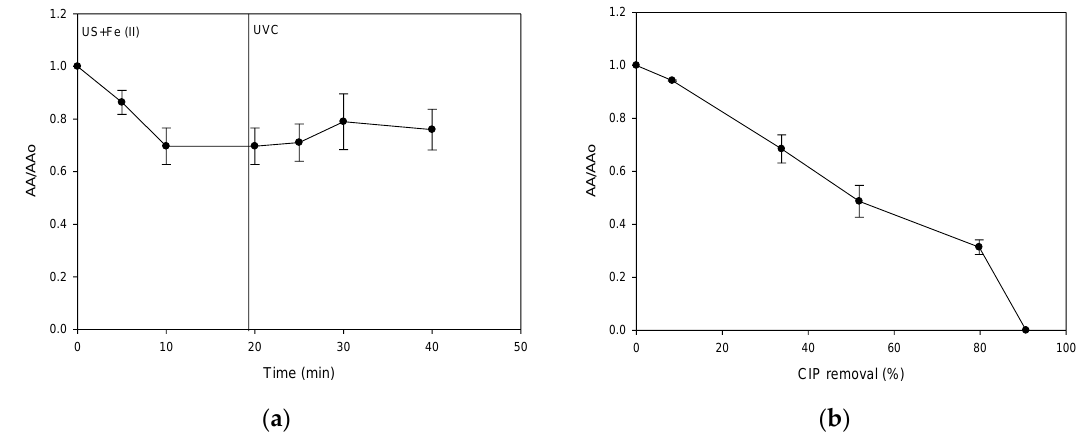
Figure 6. Evolution of the antimicrobial activity (AA). ( a ) Evolution of AA associated with CIP under the action of sF (US+ Fe (II)) followed by UVC irradiation; ( b ) Evolution of AA associated with CIP under the action of the sonochemical process alone. Experimental conditions: f: 375 kHz, P: 34.4 W, [CIP] initial : 30.6 µ mol L − 1 , [Fe 2+ ]: 1.0 mg L − 1 (18.0 µ mol L − 1 ), pH initial : 5.6, V: 250 mL, and UVC: 3.02 × 10 17 photons s − 1 .